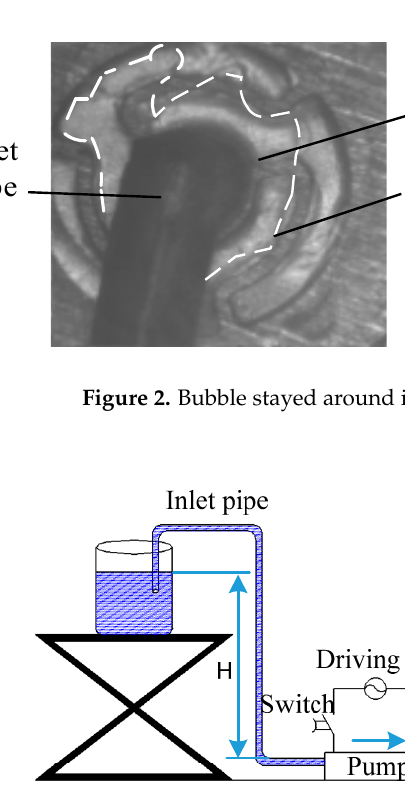
Figure 3. Air block under positive pressure.